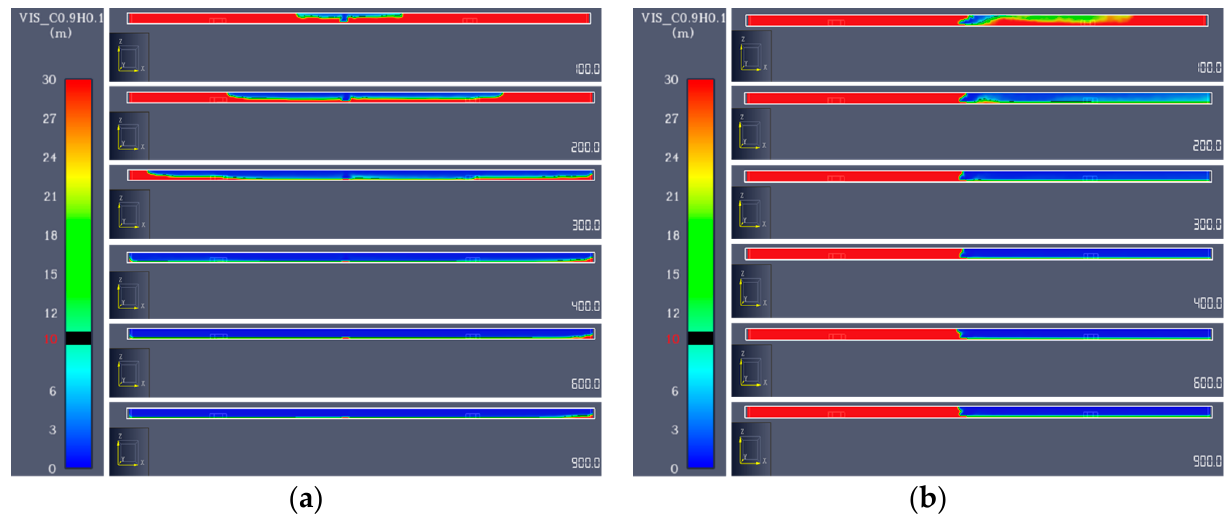
Figure 10. Changes in the longitudinal center section of visibility: ( a ) 0.5 m/s; ( b ) 3.6 m/s.